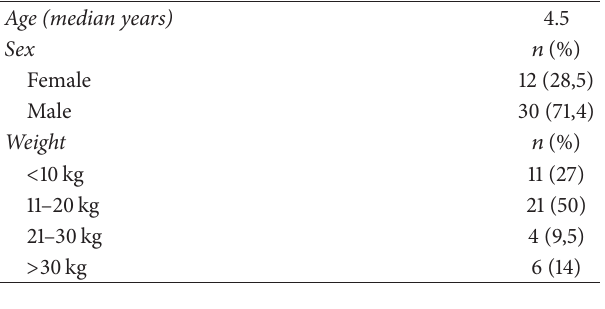
Table 1: Demographic variables.